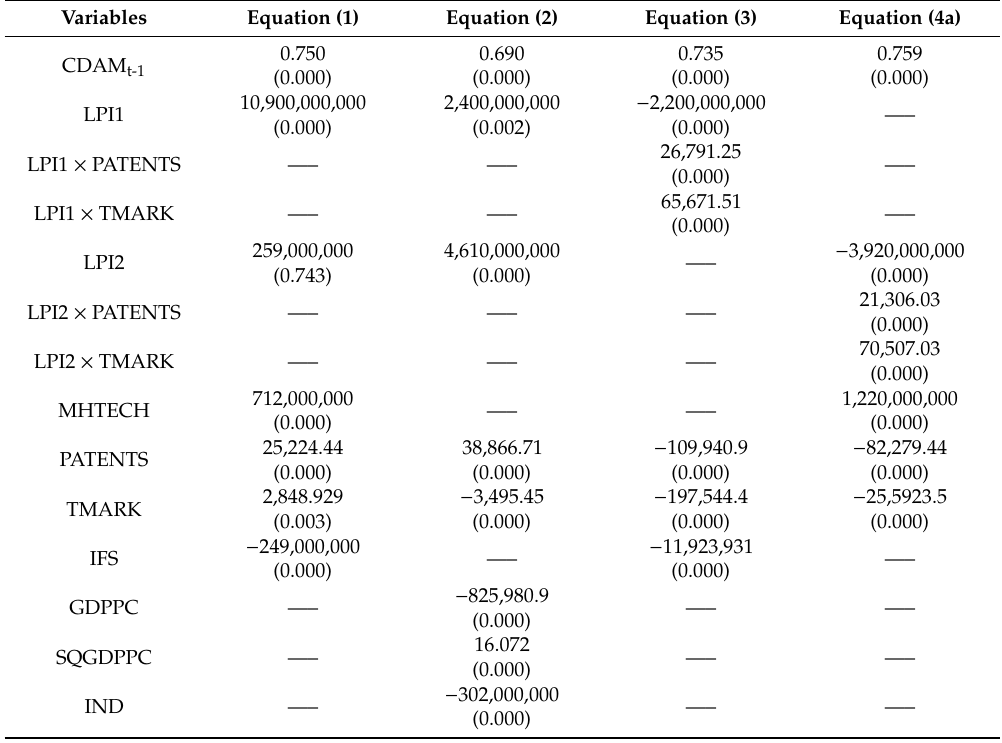
Table 5. Dynamic Panel GMM